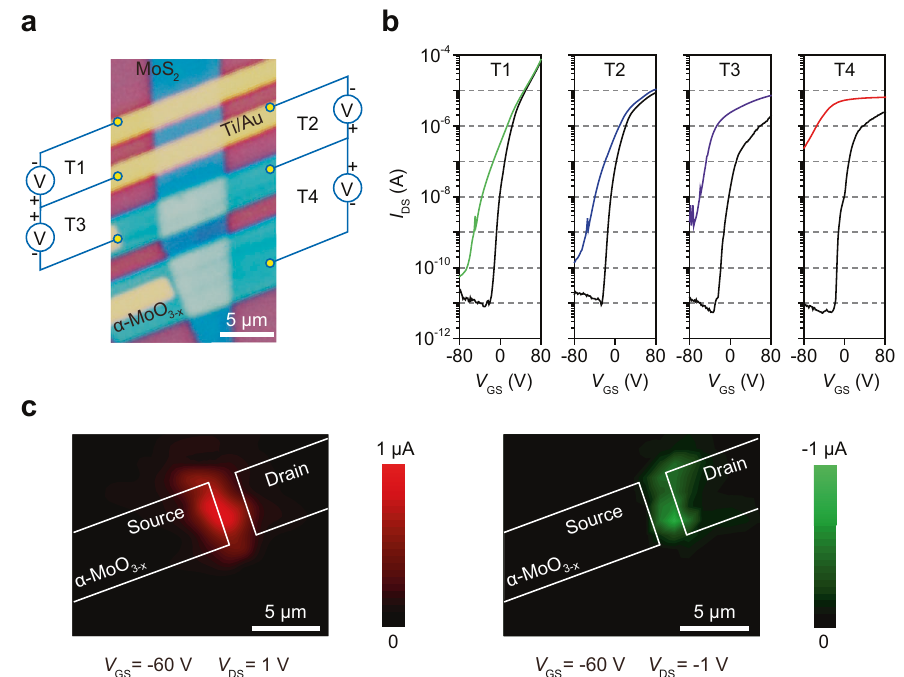
Fig. 3 The origin of the ultrahigh detectivity. a Four MoS 2 phototransistors with difference source (cathode) and drain (anode) electrodes marked T1 (Ti/ Au, Ti/Au), T2 ( α -MoO 3-x , Ti/Au), T3 (Ti/Au, α -MoO 3-x ), and T4 ( α -MoO 3-x , α -MoO 3-x ). b I DS − V GS measured in the dark (black line) and the light with a wavelength of 405 nm and a power density of 0.1 mW/cm 2 (colored line) for V DS = 1 V. The optoelectronic responses from T1 to T4 gradually increase, showing that I DS / I Dark increases from <10 to more than 10 4 at V GS = − 80 V. c Scanning photocurrent map of the α -MoO 3-x /MoS 2 / α -MoO 3-x phototransistor illuminated by a 633 nm laser with a spot size of ~2 μ m using a nano-positioning stage with a 1 μ m scanning resolution, for V GS = − 60 V and V DS = ±1 V, the color bars represents quantity of